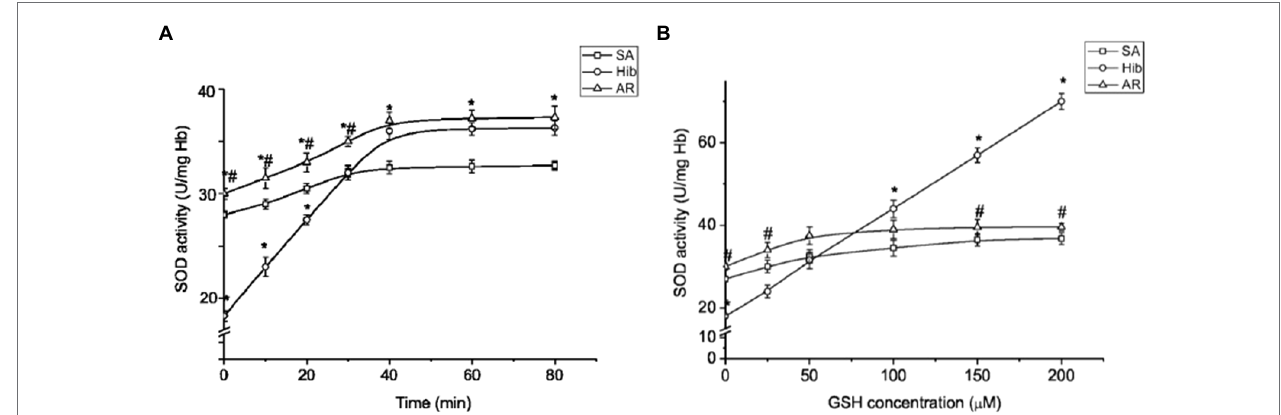
FIGURE 6 | Glutathione promotes SOD activation in ground squirrel RBCs in the torpid state. Temporal kinetics of SOD activation by exogenous GSH in hemolysate ( n = 10; A ). The effect of GSH on RBC SOD activity ( n = 10; B ). SA, summer active; HIB, hibernating; and AR, aroused. Data are expressed as mean ± SEM; * p < 0.05 vs. SA; # p < 0.01 vs.